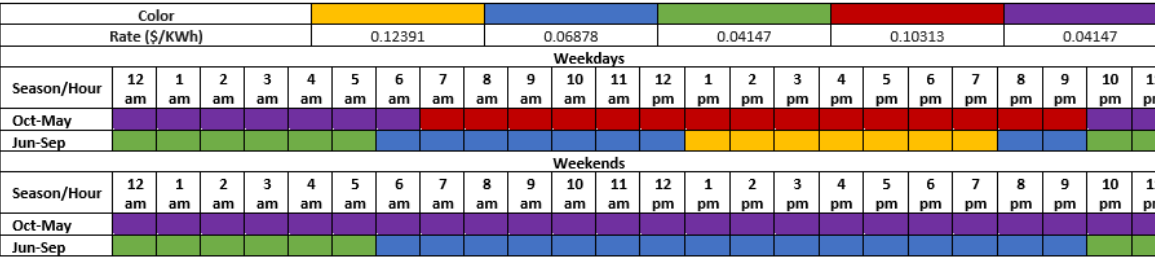
Figure A2. Rate A (KCP&L)—time-of-use. Table A3. Rate B (Leavenworth-Jefferson Electric Cooperative Inc.)—flat.